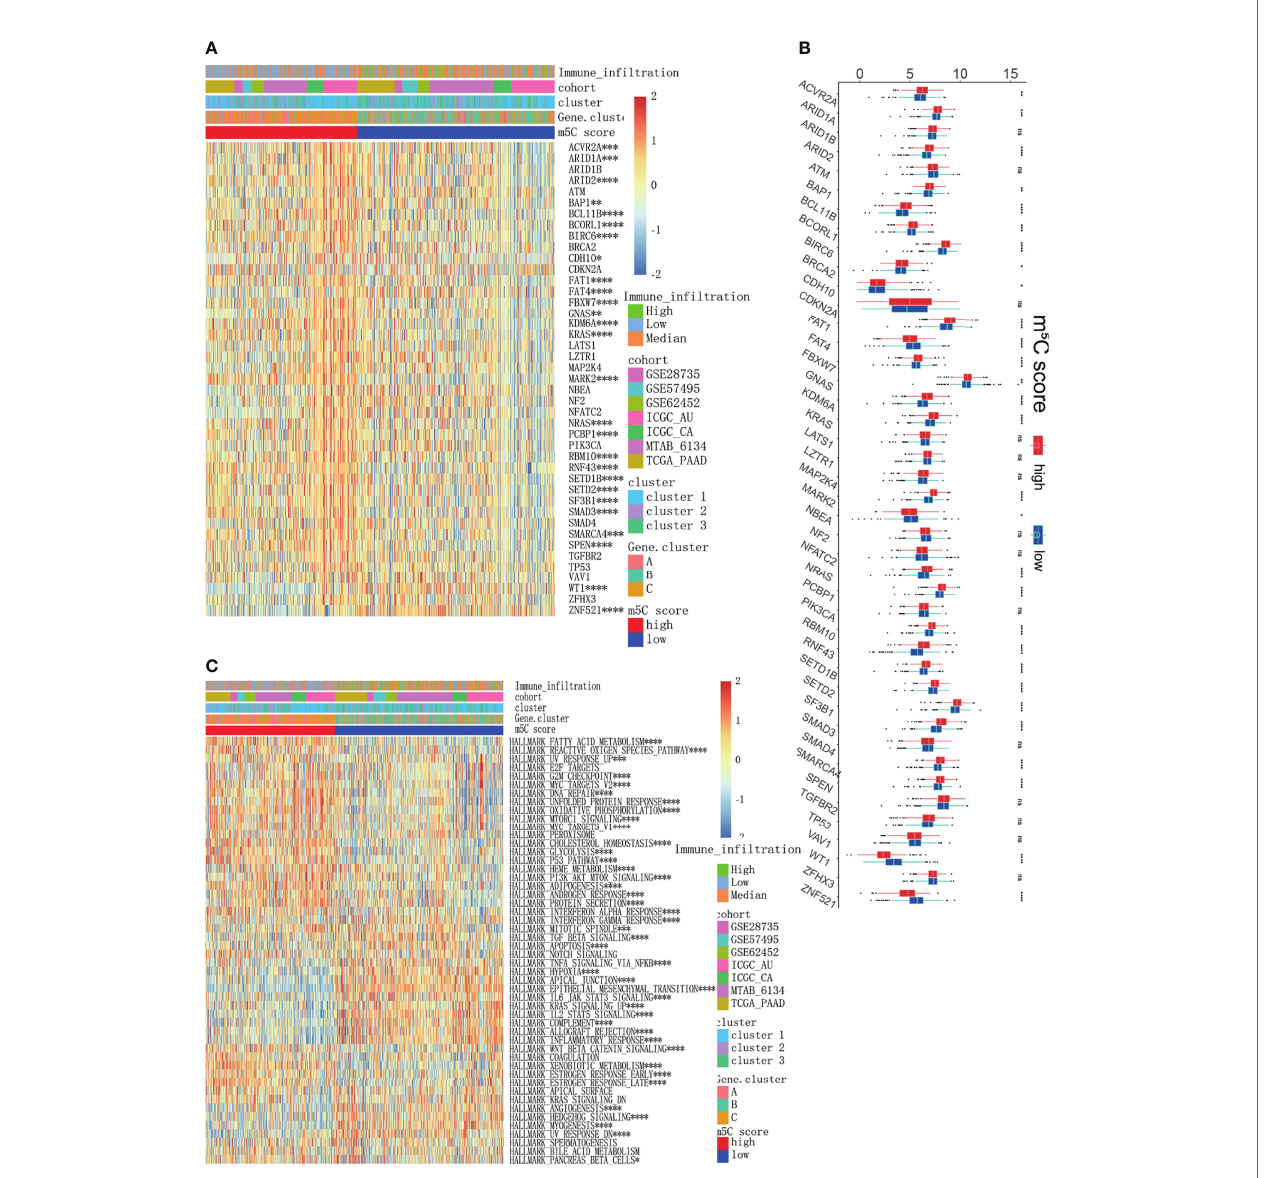
FIGURE 9 | Exploration of the mechanisms underlying the m 5 C score model. (A, B) Analysis of cancer driver genes in the high and low m 5 C score groups. (C) GSVA results of all PAAD cohorts between the high and low m 5 C score groups, which were also characterized by immune in fi ltration subtypes, clusters and gene clusters. * represents p value < 0.05, ** represents p value < 0.01, *** represents p value < 0.001, **** represents p value < 0.0001, ns means "not statistically signi fi